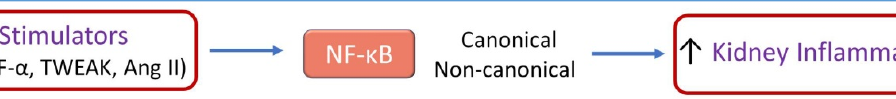
Figure 1. Nuclear factor- κ B (NF- κ B) activation in kidney disease. Various stimulators, such as Tissue